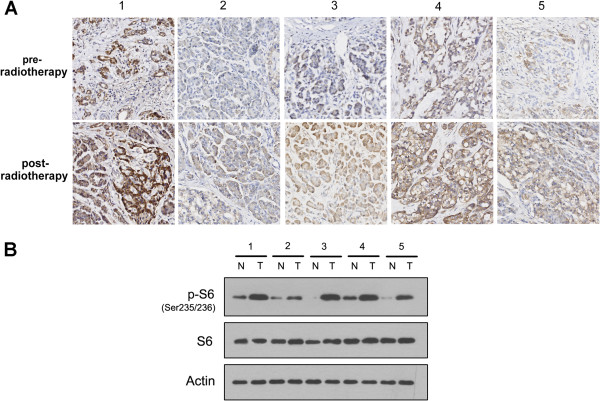
mTOR expression and activation in pancreatic cancer patients before and after radiotherapy. (A) Examination of mTOR in the tissue sections from pancreatic cancer patients pre- or post-radiotherapies by Immunohistochemistry (200 × magnification). (B) Western blot analysis of S6 and p-S6 protein in pre-radiotherapy tumors (N) and post-radiotherapy tumors (T). Actin was used as a loading control.